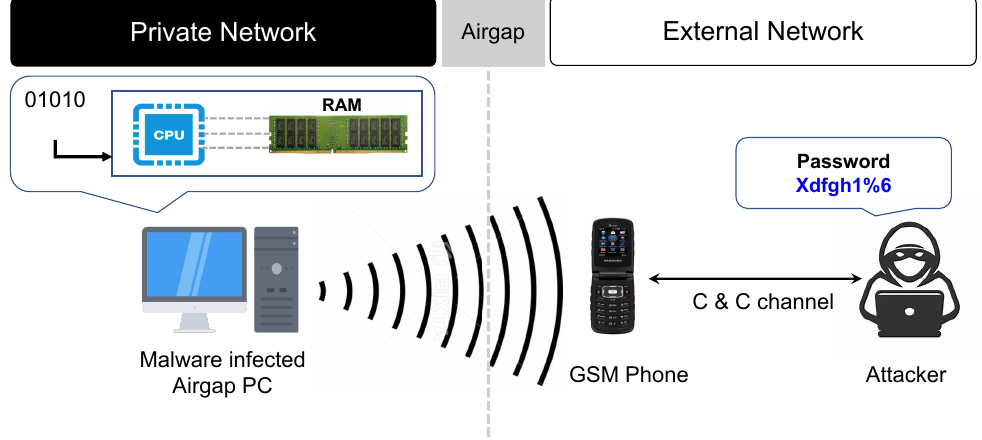
Figure 5. Conceptual diagram of air-gap attack using multi-channel memory bus